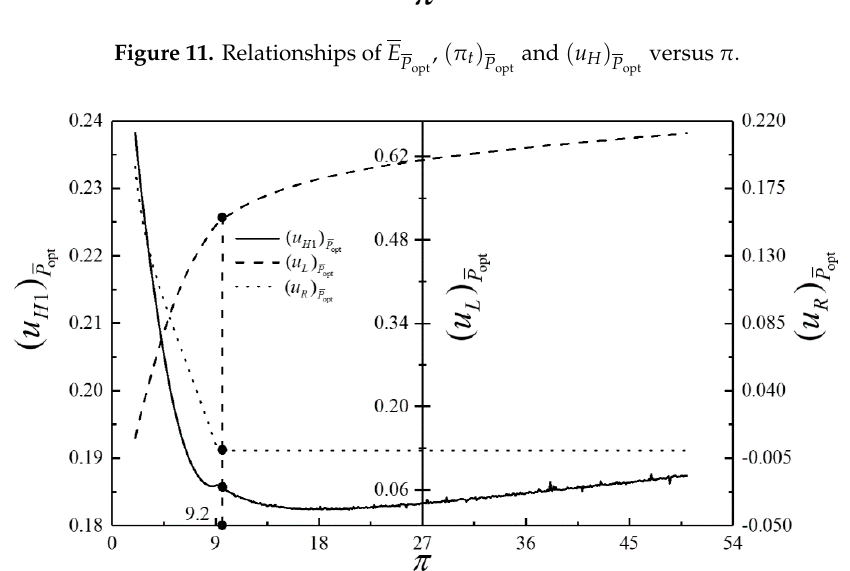
π , ( u L ) and ( u R ) versus π . P opt P opt P opt π .